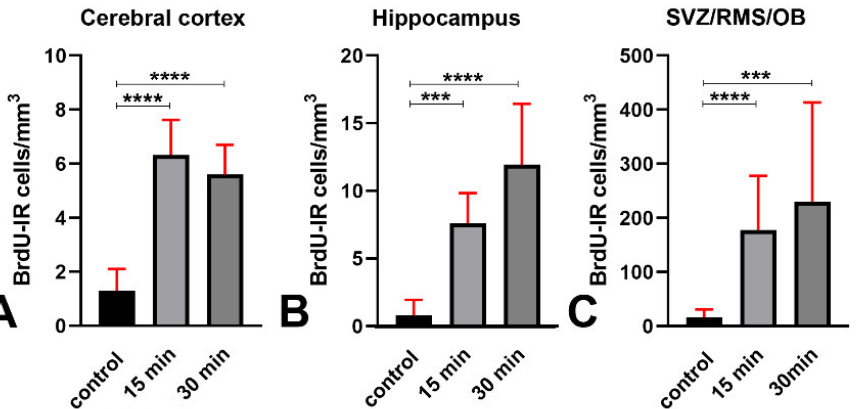
Figure 12. Effect of X-ray irradiation on the volumetric density of BrdU immunoreactive cells in the cerebral cortex ( A ), hippocampus ( B ) and SVZ/RMS/OB ( C ). Data are expressed as mean ± 95% CI *** 0.001 > p ≥ 0.0001, **** p < 0.0001. Bars are 95% CI. See Appendix I for numerical data of statistics.